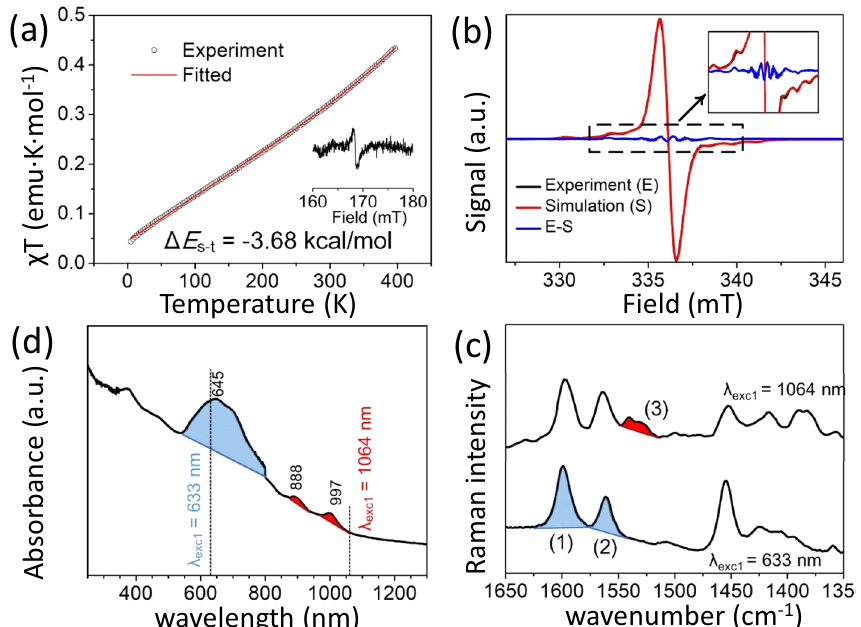
Fig. 3 Solid-state magnetic and spectroscopic properties of CAR. a Temperature-dependent plots of χ T versus T and fi tted χ T – T curve (solid line) for CAR measured at 1.0 T from 2 to 400 K. The half- fi eld transitions ( Δ m s = ±2) are shown as insets. b ESR spectra of 1 mmolL − 1 CAR in a frozen glass (toluene) at 130 K. c UV-Vis-NIR electronic absorption spectrum in solid-state of CAR at room temperature; d room temperature solid-state Raman spectra of CAR taken with the 633 nm and 1064 nm excitation laser lines.